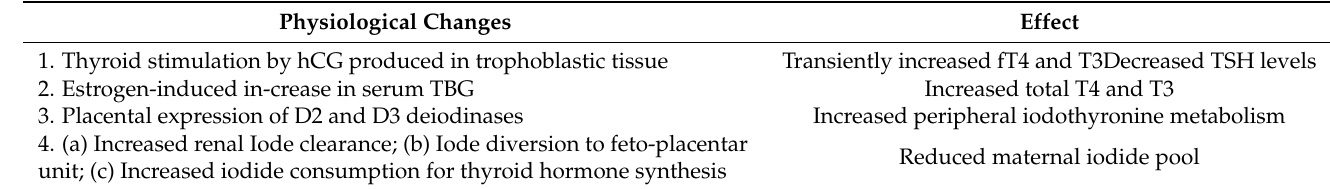
Table 1. Physiological changes that affect maternal thyroid function in pregnancy